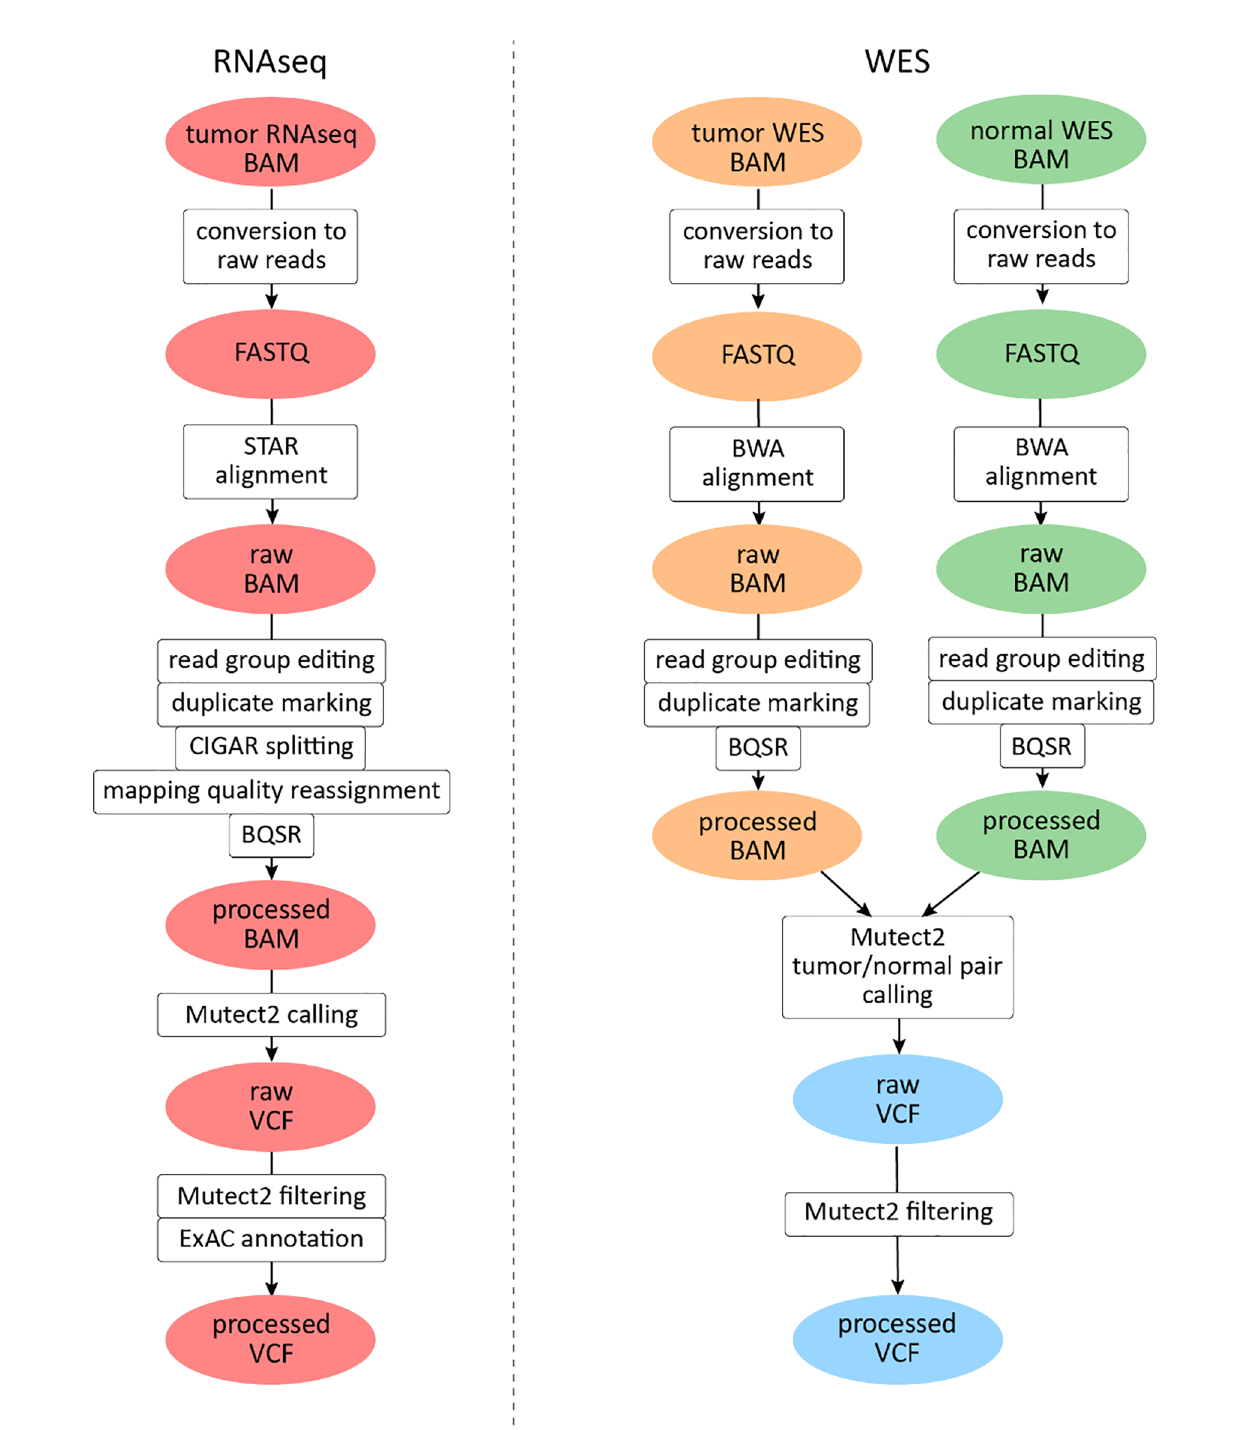
FIGURE 1 | Mutation calling pipeline for The Cancer Genome Atlas (TCGA) data analysis. File instances are shown in ovals, pipeline steps in rectangles. RNAseq fi les are highlighted in red, tumor whole exome sequencing (WES) fi les in orange, and normal WES fi les in green. Data derived from both tumor and normal WES data are shown in light